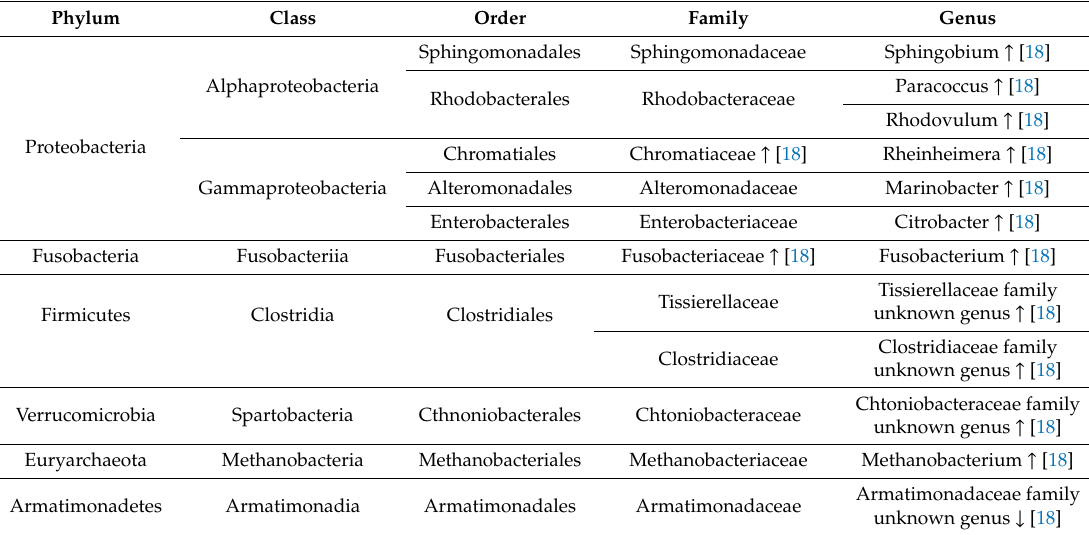
Table 5. Blood microbiome alterations in